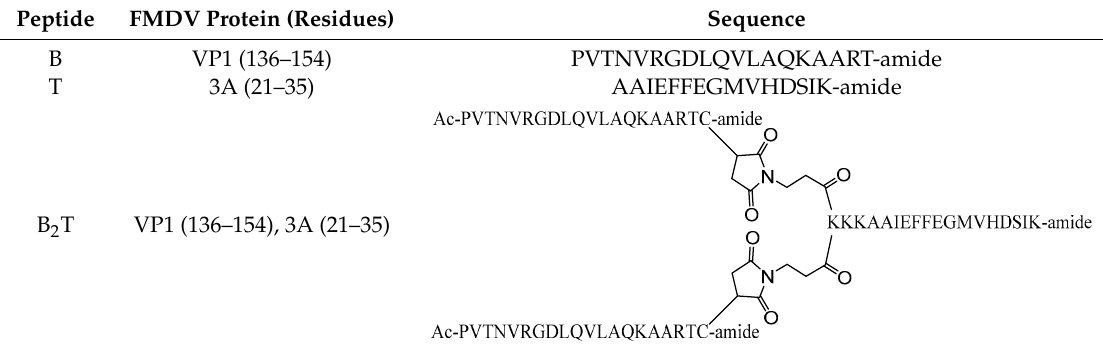
Table 1. Synthetic peptides used in this study.